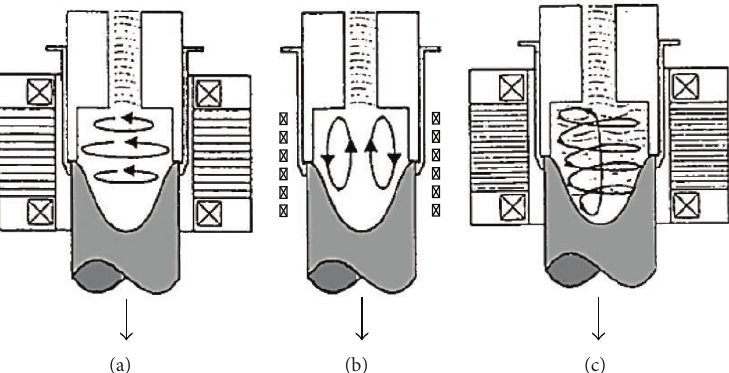
Figure 6: Schematic diagram of different flow modes system: (a) horizontal agitation; (b) vertical agitation; (c) helical agitation [23].